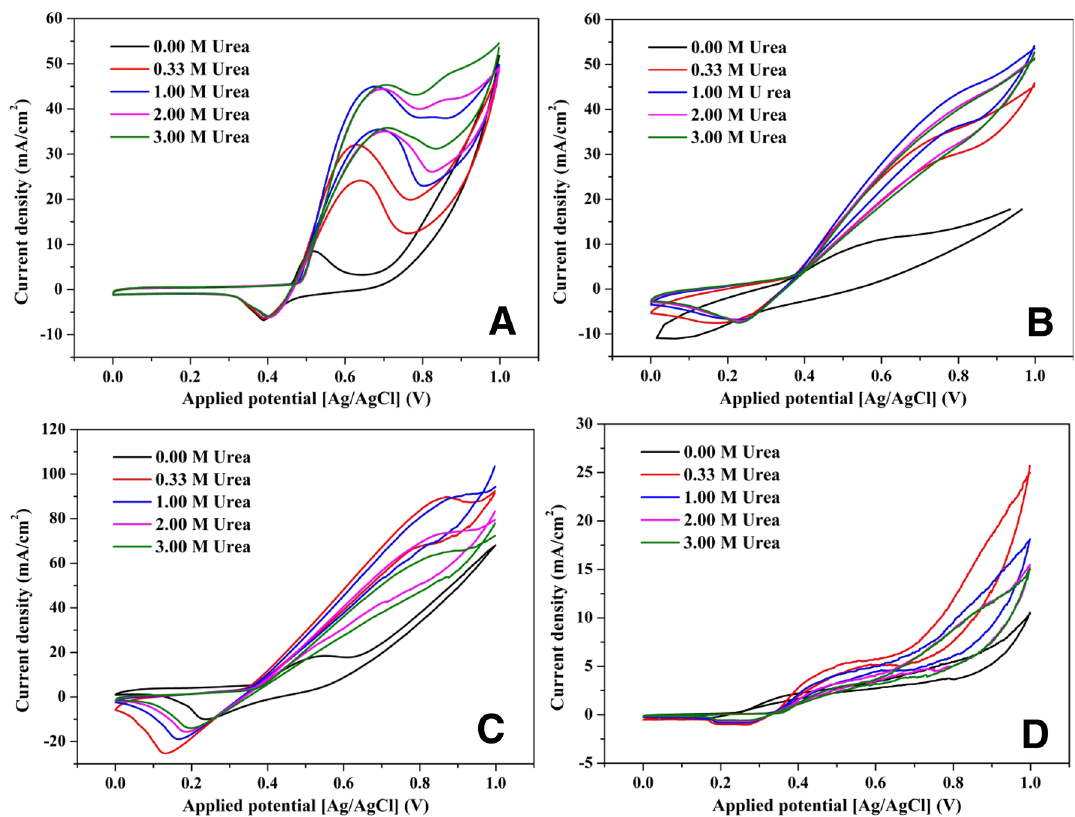
Figure 9. Electrocatalytic activity of the proposed NiMo-incorporated carbon nanofibers toward urea oxidation at different Mo precursor contents; 5 ( A ), 10 ( B ), 25 ( C ); and 35 ( D ), at 850 °C and 50 mV/s scan rate and 25 °C.